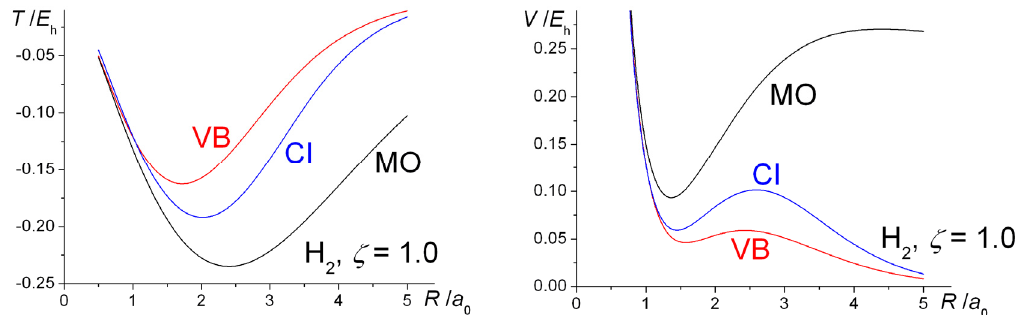
Figure 14. Kinetic (left panel) and potential energies (right panel) of H 2 computed in a minimal basis of two hydrogen AOs with a fixed exponent of 1, as obtained by the MO, VB, and CI methods (relative to separated limit of two hydrogen atoms). The total H 2 energies in Figure 13 are the sums of kinetic and potential energies shown here.